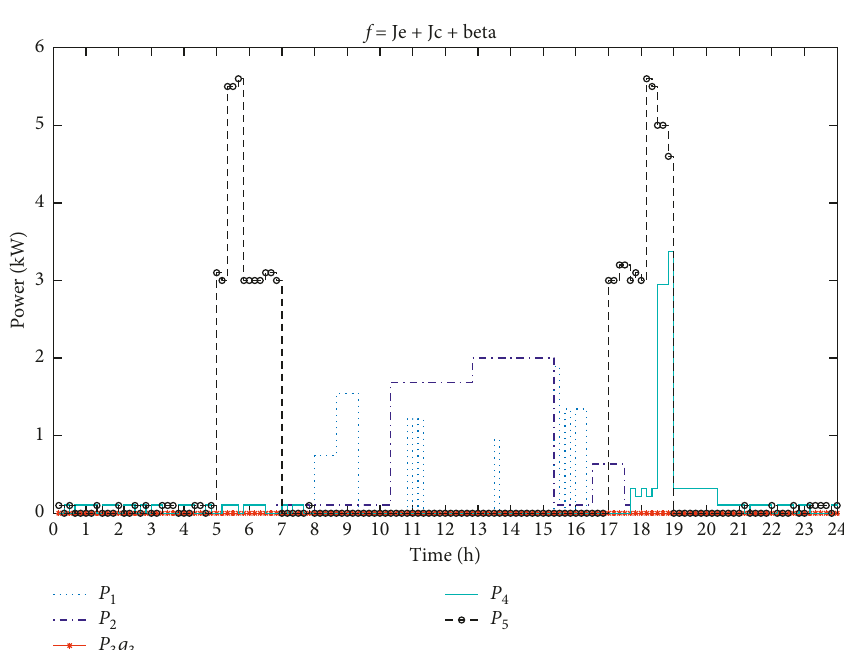
Figure 7: Power dispatch of the new design in case (iii).